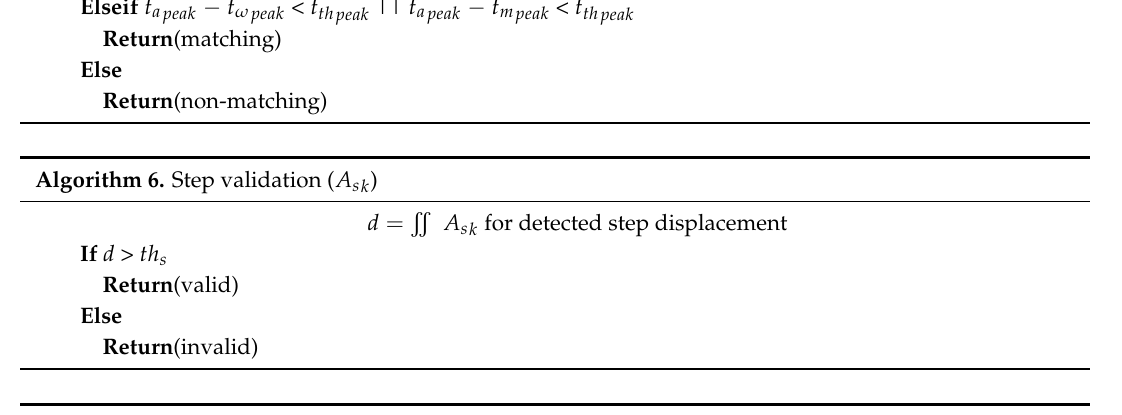
Algorithm 7. Step detection